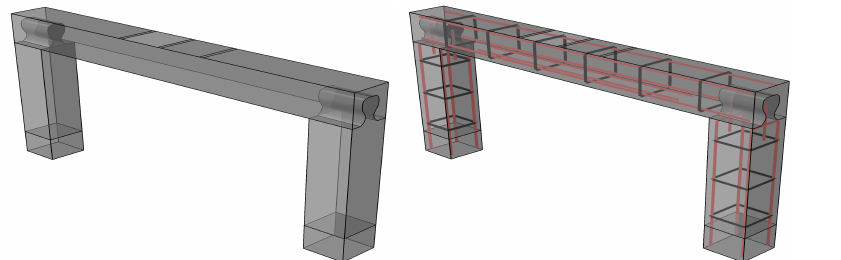
Figure 13. F5, Rebar layout and geometrical dimensions.